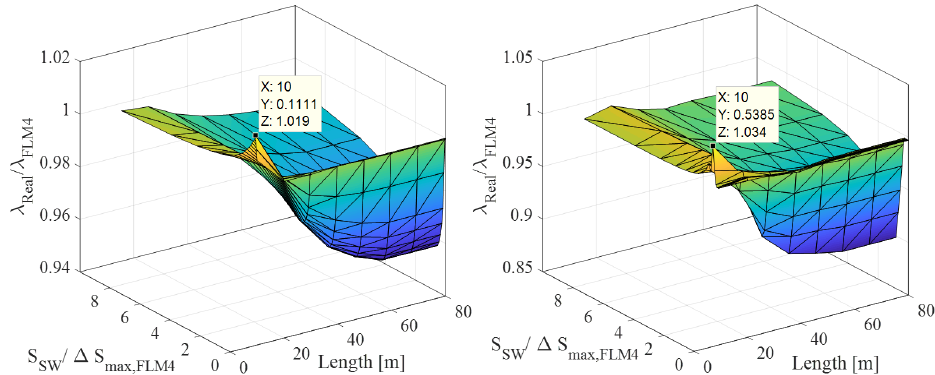
Figure 14. The ratio of λ HFMI for original real traffic in Sweden and λ HFMI for FLM4 (local traffic) calculated for mid-span section (to the left ) and mid-support section (to the right ).